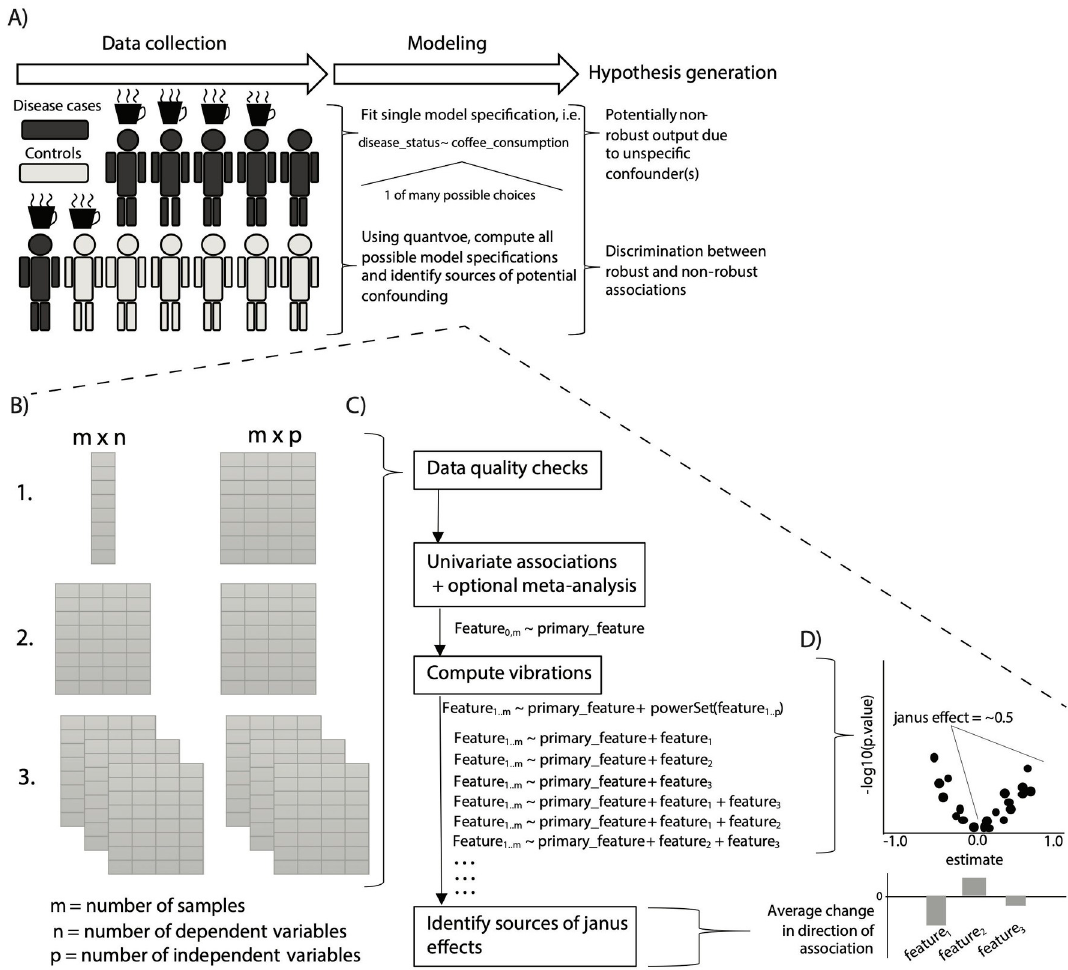
Fig 1. Overview of the algorithmic approach and its place in the hypothesis generation toolkit. (A) The process/paradigm of “data- driven” discovery. First, high-dimensional data are collected on a set of individuals with a given phenotype (i.e., a disease) as well as controls (individuals without the phenotype). The researcher selects a modeling strategy, most often just one, and computes associations between the phenotype of interest (a “Y”) and a particular feature (an “X,” like coffee in the example). The resultant associations yield associational “hypotheses” regarding the relationship between the X and the Y, but only fitting one model specification can yield nonrobust results. Quantvoe replaces this middle step of choosing one model, instead attempting to fit up to every possible model specification, thereby charting a course to robust hypothesis generation. (B) Quantvoe takes 3 types of input data, all in the form of pairs of data frames (tables), either at the command line or in an interactive R session: (1) a single dependent variable and multiple independent variables; (2) multiple dependent variables, or (3) multiple datasets. (C) There are 4 main steps—checking the input data, computing initial univariate associations, computing vibrations across possible adjusters, and quantifying how adjuster presence/absence correlates to changes in the primary association of interest. (D) Following computing VoE, we evaluate the results by measuring Janus effect (the fraction of associations greater than 0) and estimating the impact of different adjusters on the change in correlation